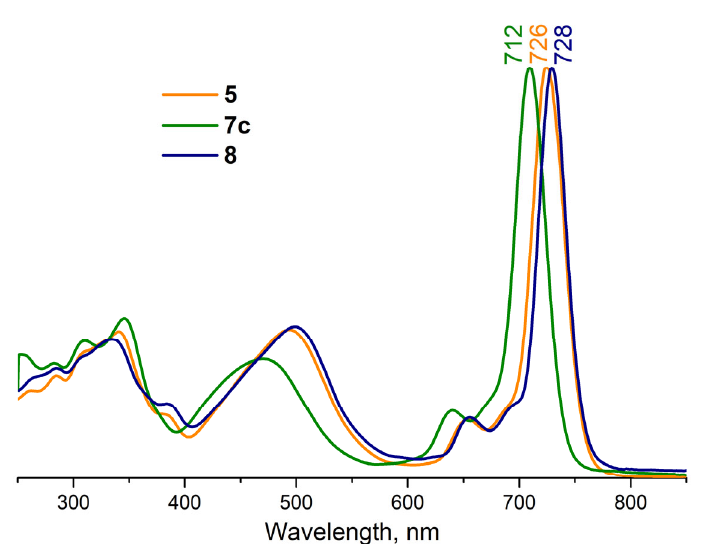
Figure 3. Normalized UV–vis spectra of P(V)Pcs with different axial ligands in DMSO.